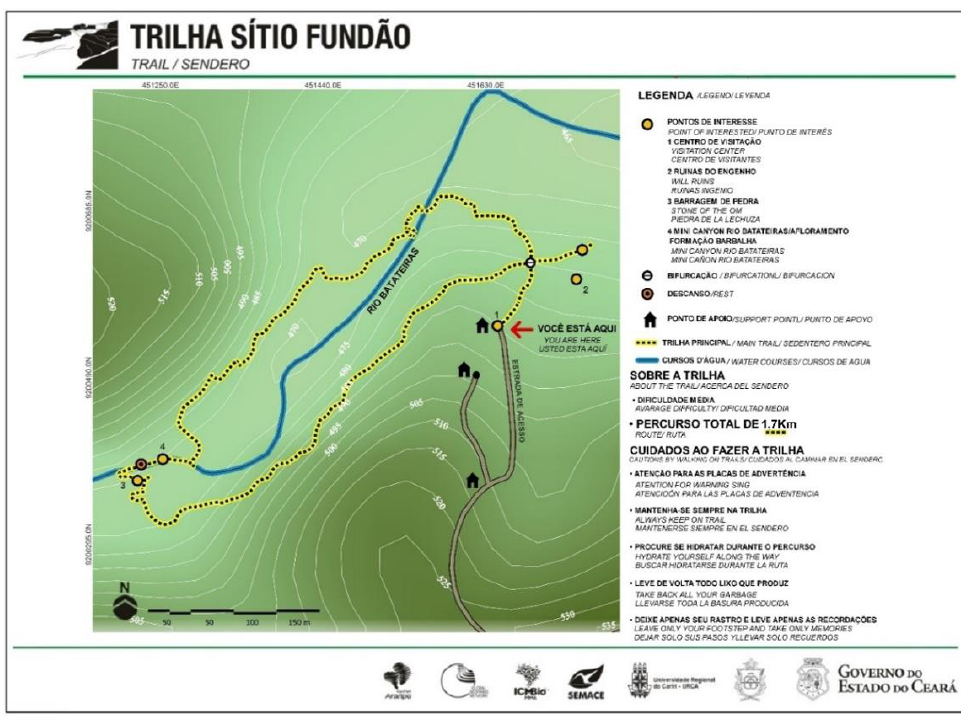
Figure 2. Sítio Fundão Trail in Batateiras Geosite. Source: Trail Signaling Plan Araripe UGG [82], Figure 2. S í tio Fund ã o Trail in Batateiras Geosite. Source: Trail Signaling Plan Araripe UGG [82], adapted from research. adapted from